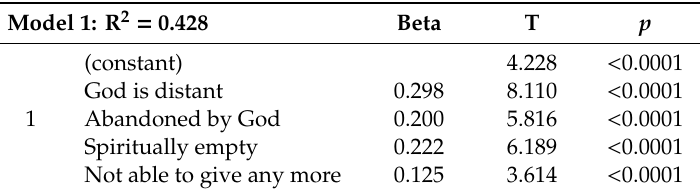
Table 4. Regression analyses among CLP.